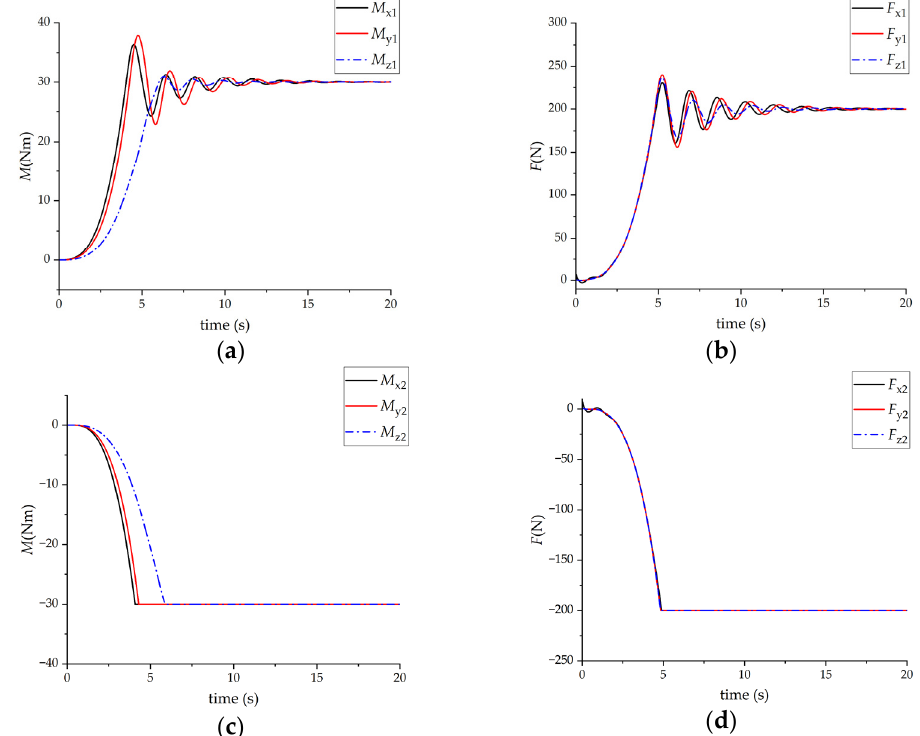
Figure 13. The output of the virtual force sensor in a state of mutual antagonism: ( a ) output torque profiles of the virtual force sensor 1; ( b ) output force profiles of the virtual force sensor 1; ( c ) output torque profiles of the virtual force sensor 2; and ( d ) output force profiles of the virtual force sensor 2.